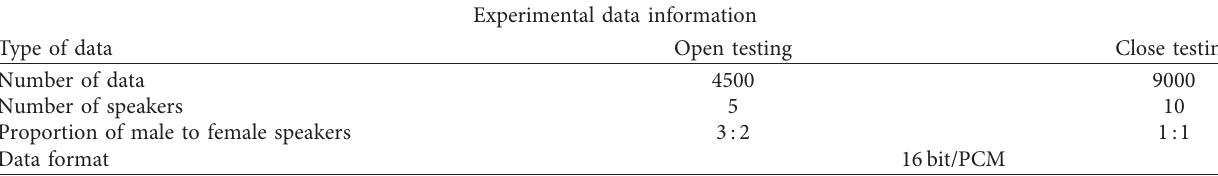
Table 1: Experimental data information